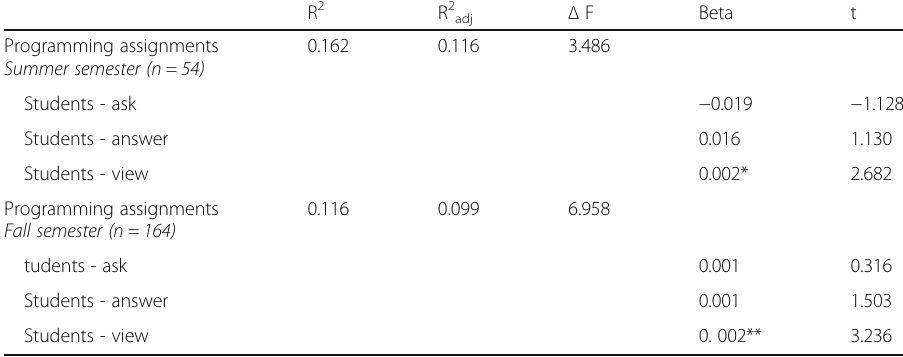
Table 4 Linear regression analysis of student online Q & A behaviors on their performance of programming